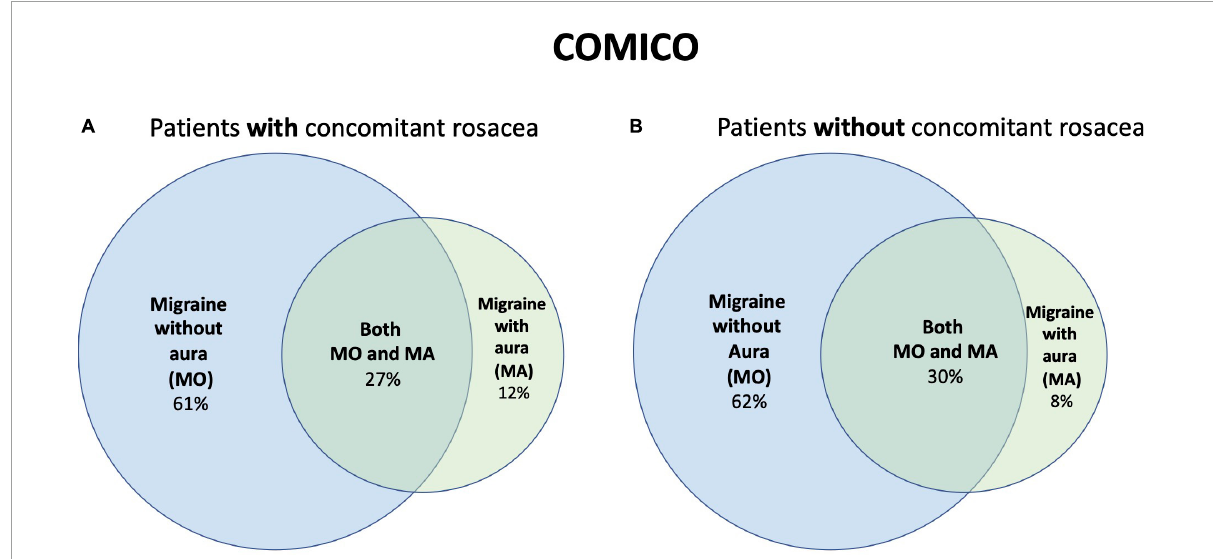
FIGURE2 Distribution of migraine subtypes in COMICO in patients, (A) with concomitant rosacea; (B) without concomitant rosacea. COMICO, Copenhagen Migraine Cohort.